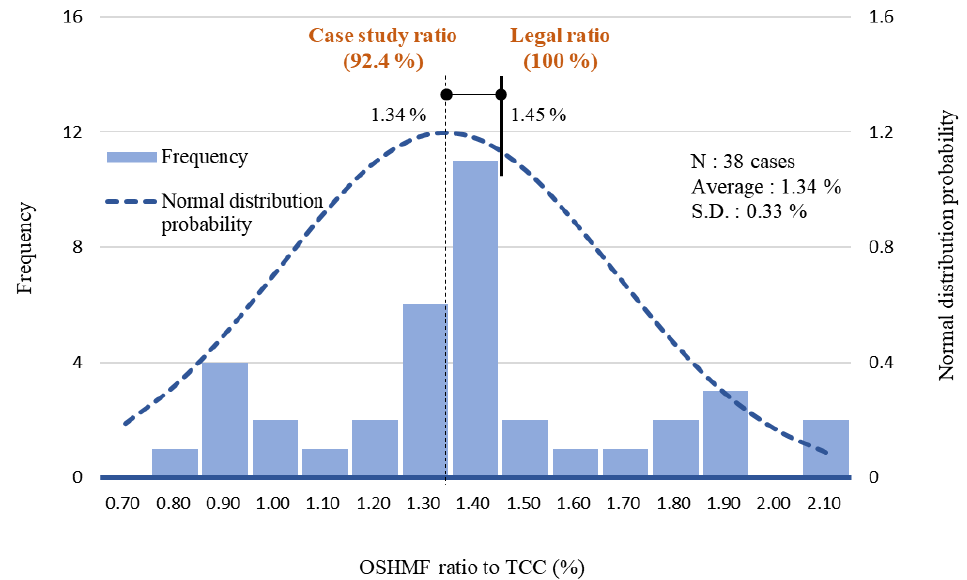
Figure 4. Frequency and normal distribution probability of the ratio of occupational safety and health management funds (OSHMF) to